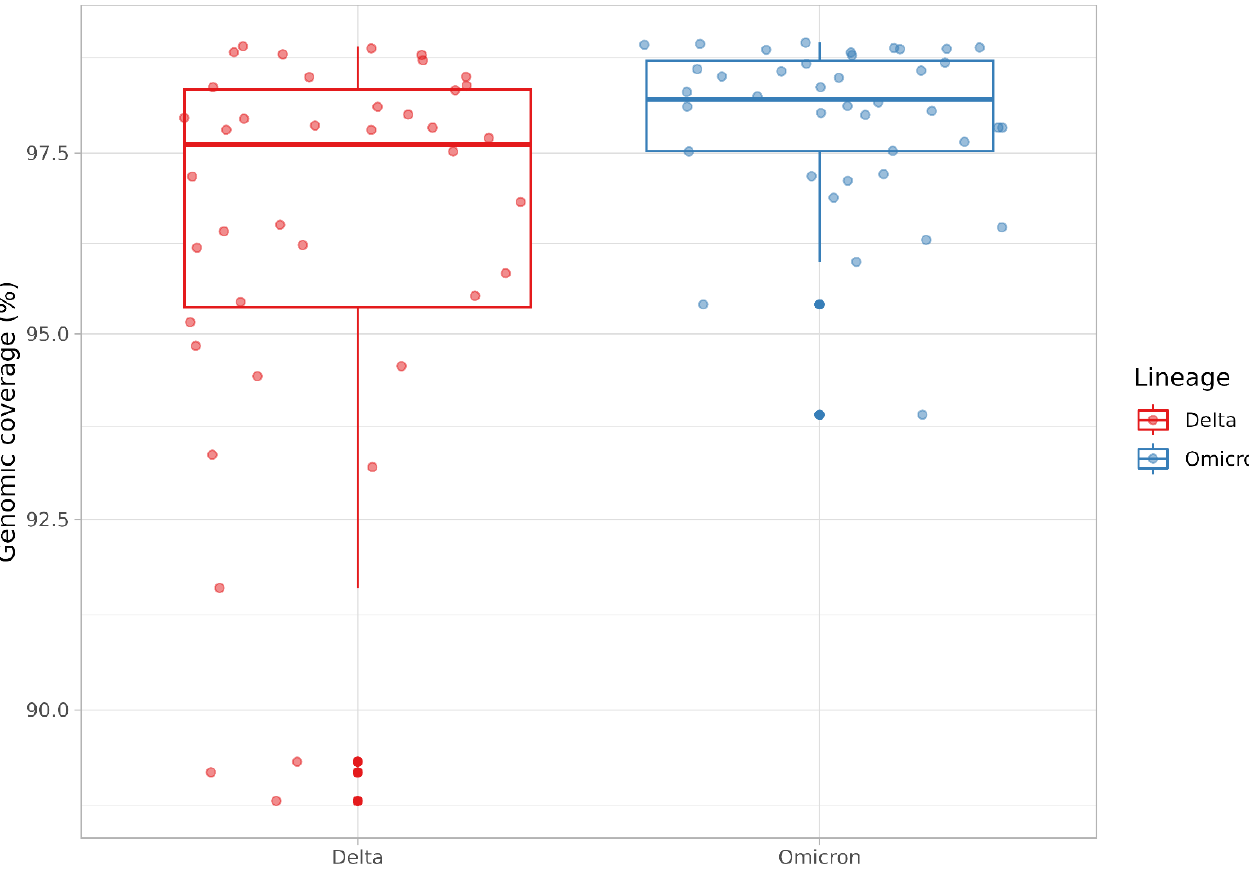
Figure 6. Genomic coverage for Delta and Omicron SARS-CoV-2 samples prepared with the custom primer panel approach. Boxplots shows percent genomic coverage for Delta (red) and Omicron (blue) variants.